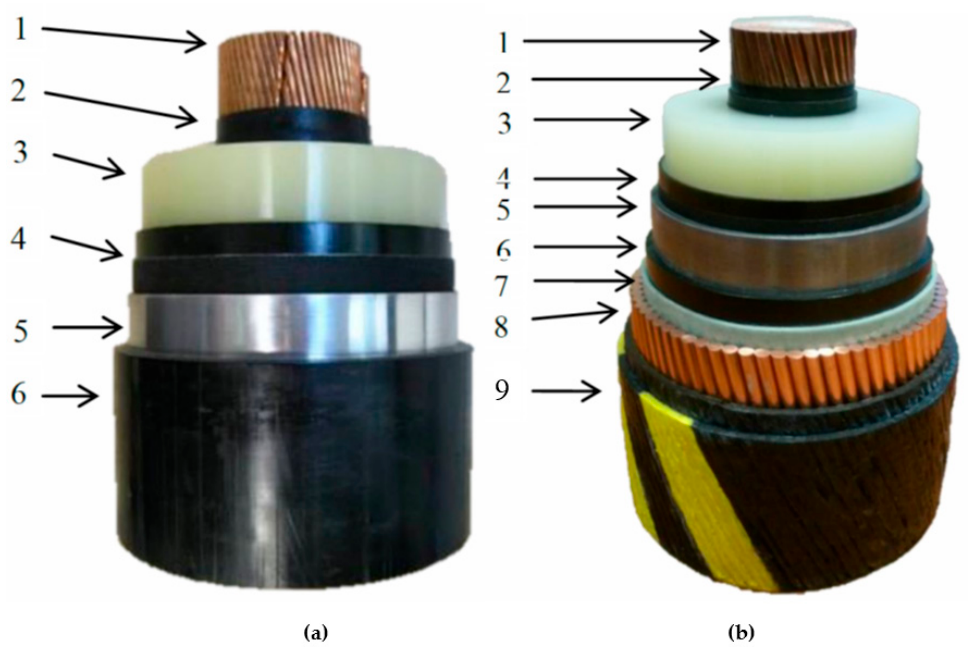
Figure 1. ( a ) Land Milliken-type cable; ( b ) Submarine armoured single-core cable [5].